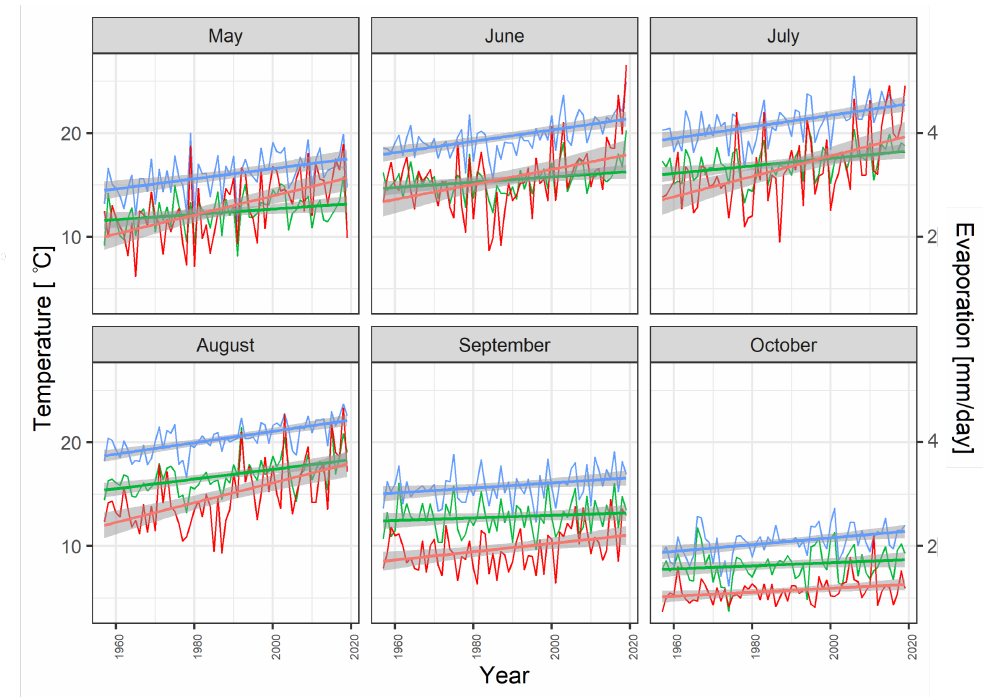
Figure 1. Mean monthly temperature (green lines), water temperature (blue line) and evaporation (red line) at Hlasivo evaporation station for period 1957–2019.